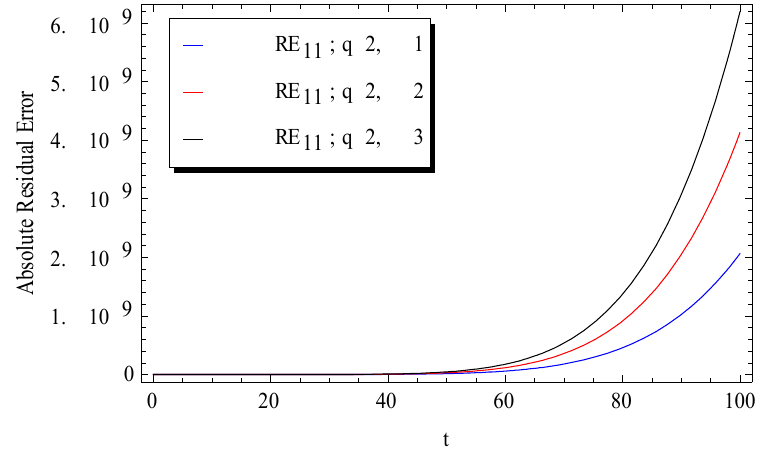
Figure 9. Effect of initial condition λ on the absolute remainder error at q = 2.